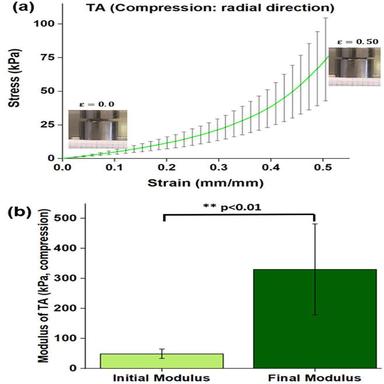
(a) TA tested in compression in the radial direction up to a strain level of ε = 0.50 showing the increased stiffness with increasing strain (b) Modulus of TA in compression showing the strain-stiffening behaviour at higher strain.